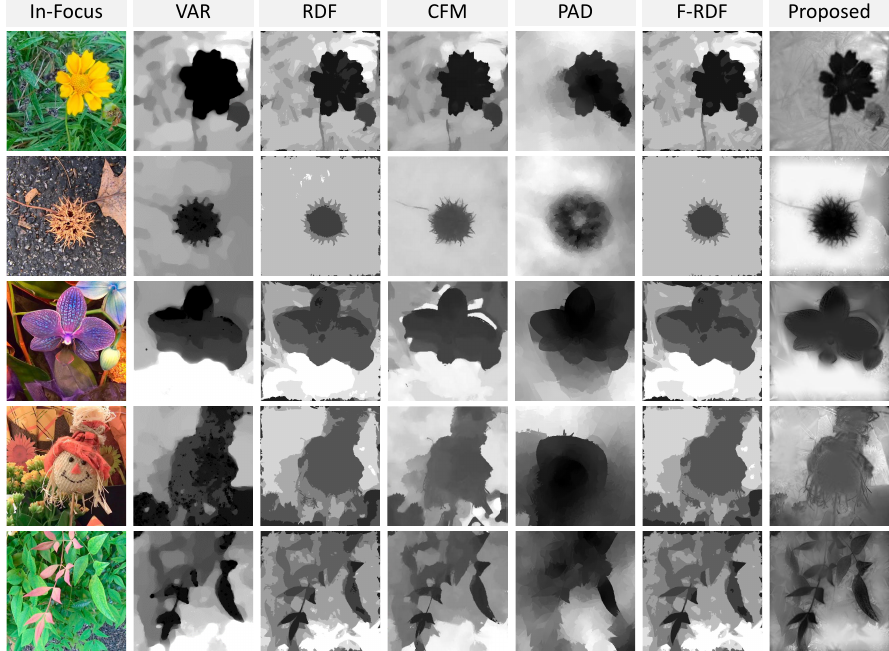
( a ) Qualitative evaluation on three samples (toy- 6 frames, Buddha-25, flower-12). From top to down: In-focus image (with highlighted region) and cropped part of recent methods PAD, CFM, RDF-20, and last row shows proposed method’s result). Our result shows more accurate depth with details even in challenging parts of the scene. Note that depth images for CFM [38] method were cropped from the original paper. Figure 18. ( a ) Quality of our method; ( b ) initial-depth and final-depth results.